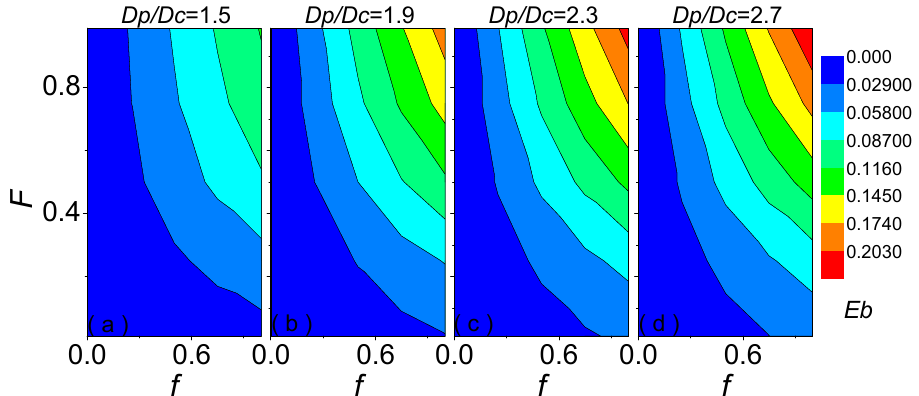
Figure 5. Absorption enhancement of BC reduced by the blocking effect of the absorbing coating ( E b ) as functions of the coated volume fraction of BC ( F ) and the coating absorbing volume fraction ( f ). Four shell/core ratios of 1.5, 1.9, 2.3, and 2.7 are shown from left to right. A BC fractal dimension of 2.8 and log-normal size distribution with r g of 0.075 µ m and σ g of 1.59 are considered.